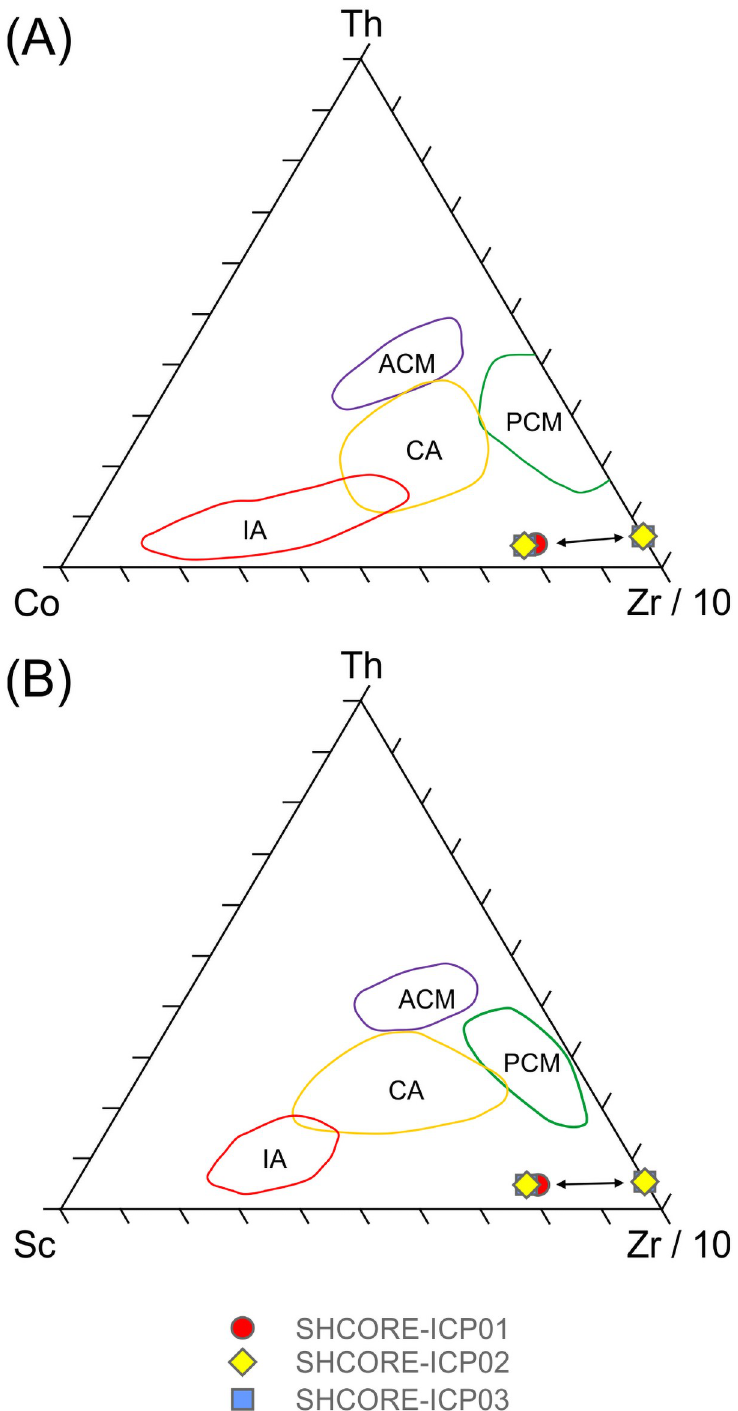
Fig 22. (A) Th-Zr/10-Co and (B) Th-Zr/10-Sc trace element discrimination diagrams for the three subsamples from the Phillips’ Core (Stone 58, Stonehenge). Co and Sc were below detection limit in all three samples. For plotting, the samples are shown as arrays defined by Sc and Co concentrations at both detection limit (1 ppm) and 0 ppm. Field names: IA—Island Arc; CA—Continental Arc; ACM—Active Continental Margin; PCM—Passive Continental